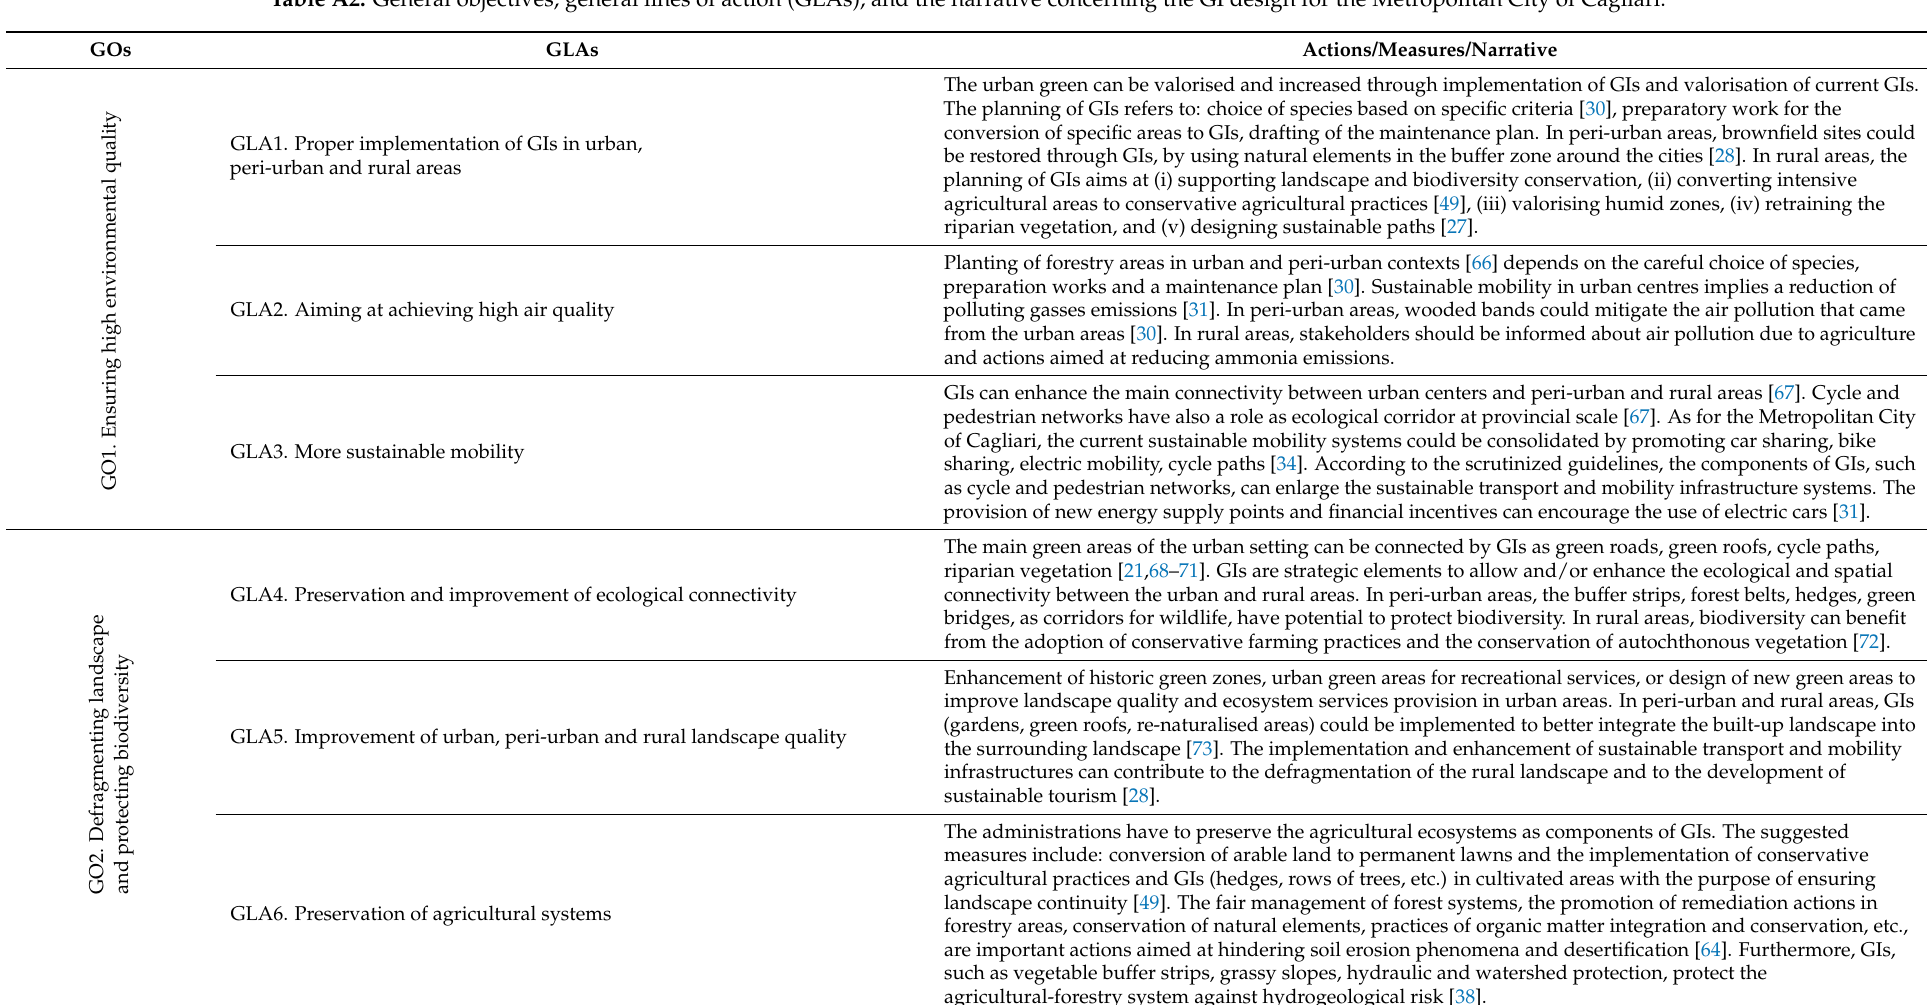
Table A2. General objectives, general lines of action (GLAs), and the narrative concerning the GI design for the Metropolitan City of